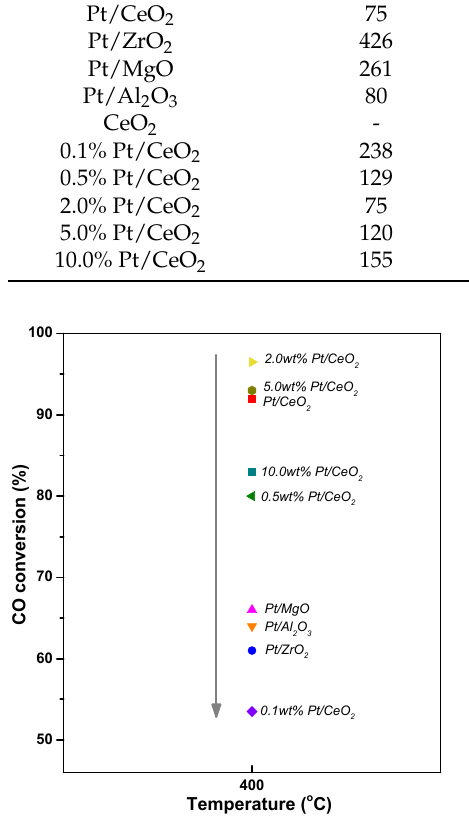
Figure 9. CO conversion of Pt-based